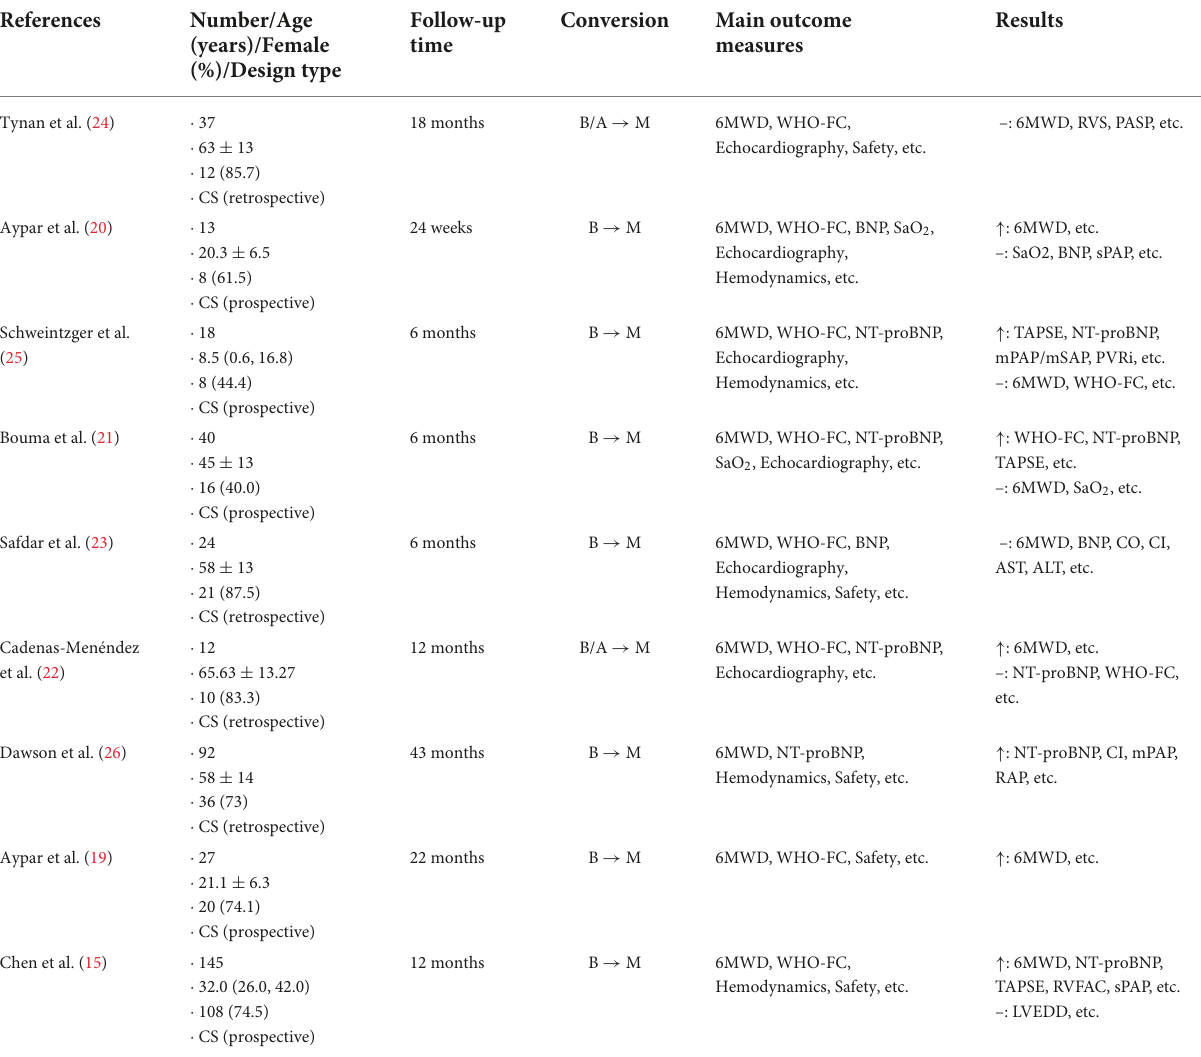
TABLE 1 Characteristics of included